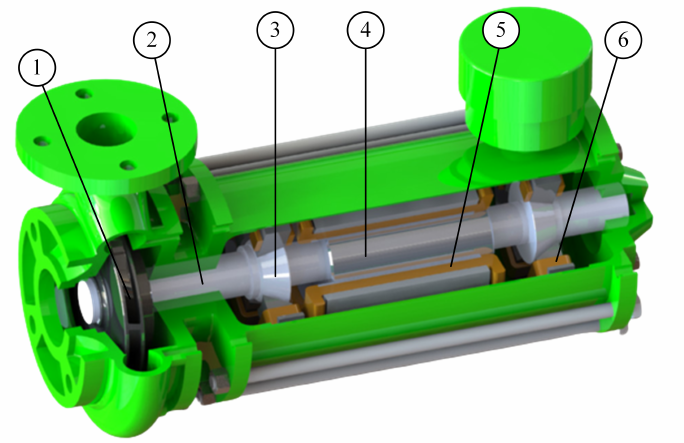
Figure 1. A canned motor pump with CAMB: (1) impeller; (2) centering tip; (3) conical geometry; (4) rotor; (5) electric motor; (6) magnetic